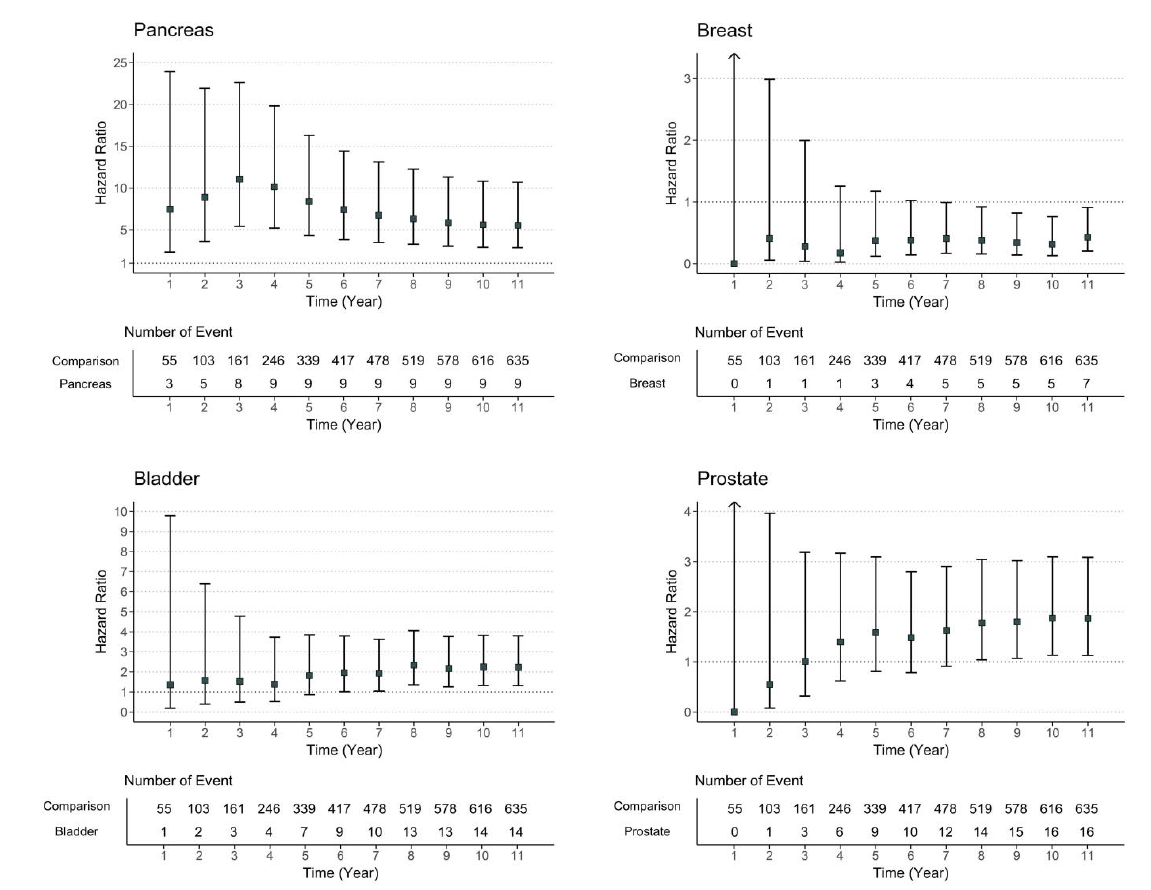
Figure 6. Risk of diabetes-associated complications in patients with pancreas, breast, bladder, and prostate malignancy by time.